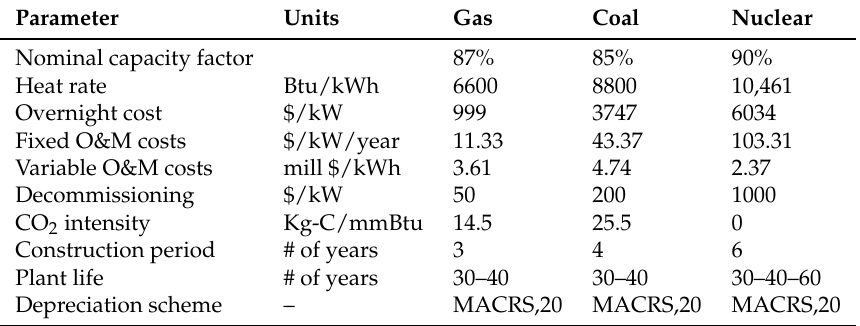
Table 2. Technical and cost assumptions. ‘mill’ stands for 1/1000. Depreciation is developed according to the MACRS (Modified Accelerated Cost Recovery System) scheme. Source: Annual Energy Outlook 2019 [20].